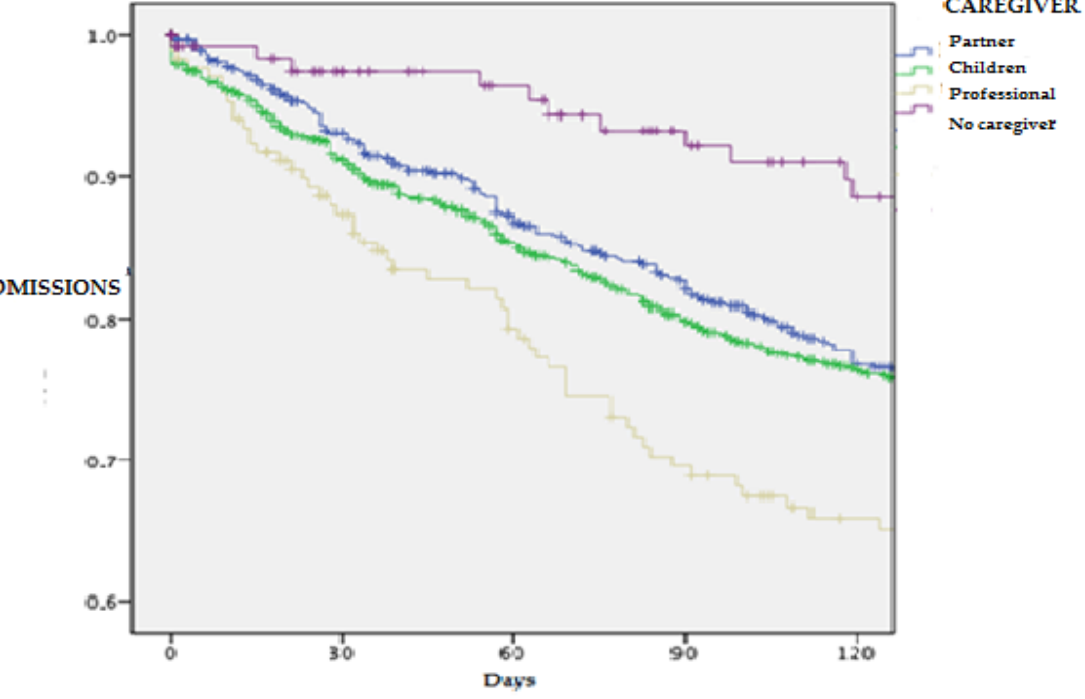
Figure 1. Survival analysis for readmissions in patients with HF according to caregiver type at 120-day follow-up.